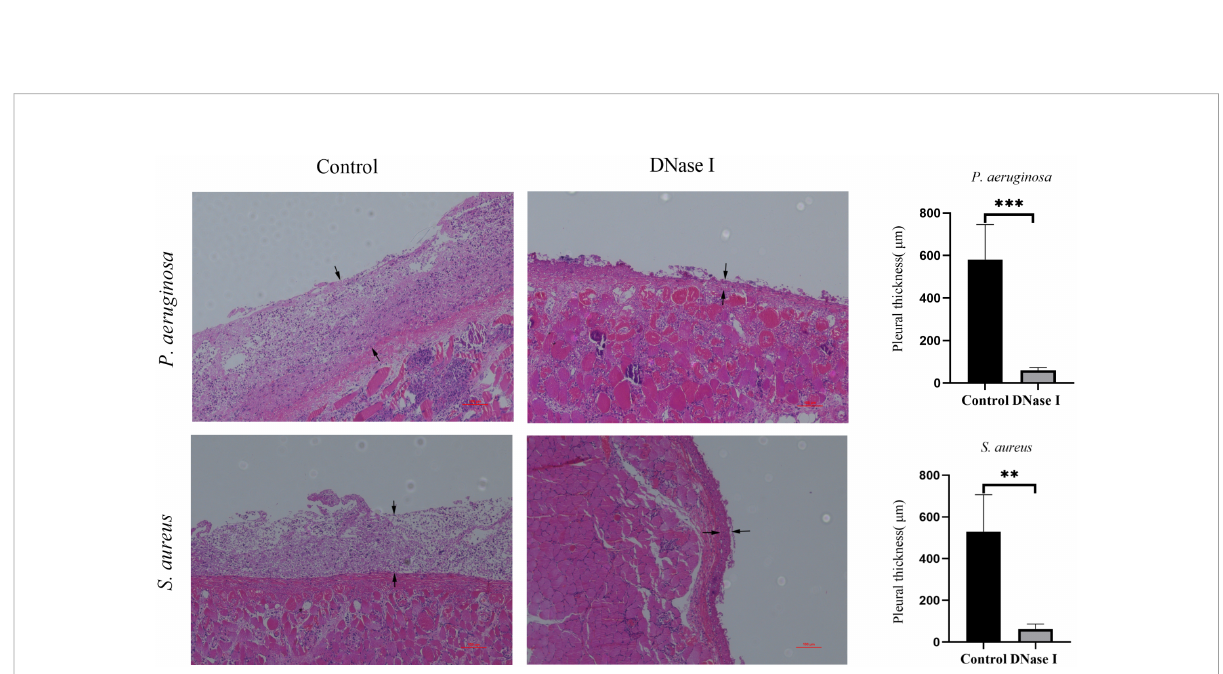
FIGURE 8 Morphological changes of the parietal pleura (H&E staining, 100×). The area between the two black arrows is the pleura. In the control rabbits, we observed parietal pleura thickening, accompanied with many in fl ammatory cell in fi ltrations. In the DNase-I treated rabbits, the parietal pleura was slightly thickened with only mild in fl ammation. The pleural thicknesses are presented as mean ± SD. An asterisk indicates signi fi cant difference; ** indicates p < 0.01 and *** indicates p < 0.001, compared with the values in the drug-free control group using t -tests (n =